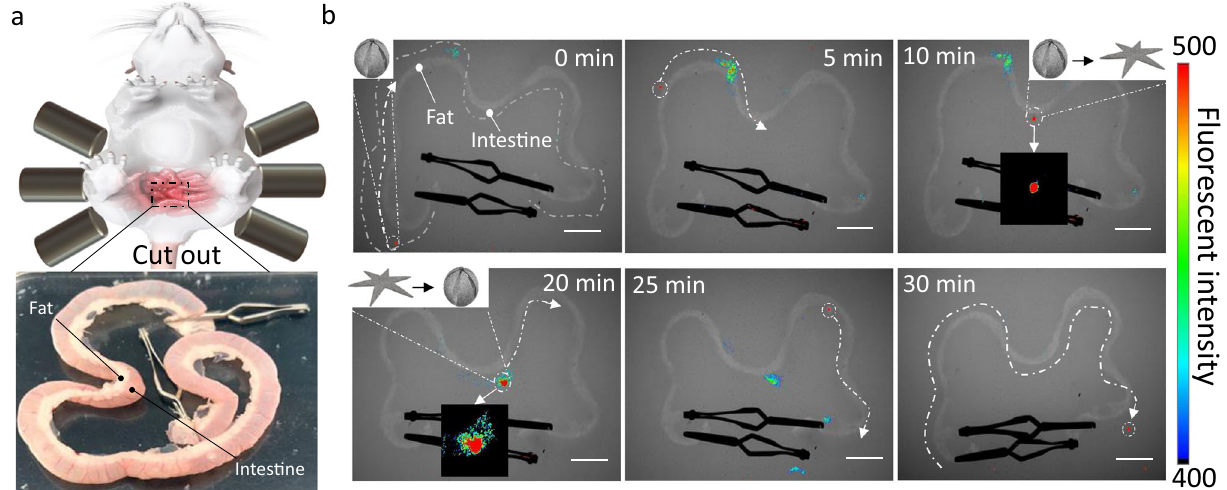
Fig. 8 Magnetic actuation of the ISME and ISME transformation in the intestine ex vivo. a Ex vivo model of a rat intestine. The rat intestine was cut out from the SD rat before the ex vivo test. b Ex vivo transformation and transportation of ISME carrying MNPs and fl uorescent microbeads controlled by an external magnetic fi eld. Scale bar: 2